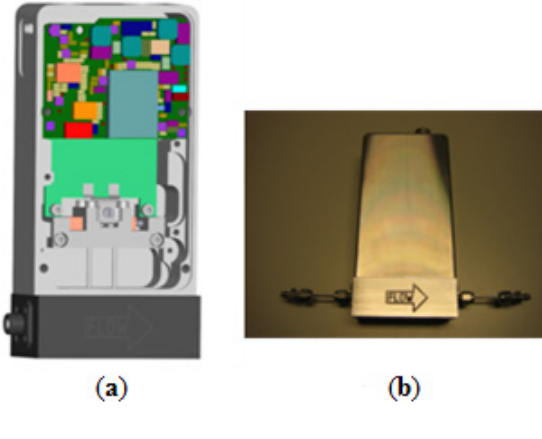
Figure 1. Micro Coriolis mass flow sensor integrated into a robust housing using a custom-made chip holder. 1/16” stainless steel tubes are connected to the chip: ( a ) First design; ( b )